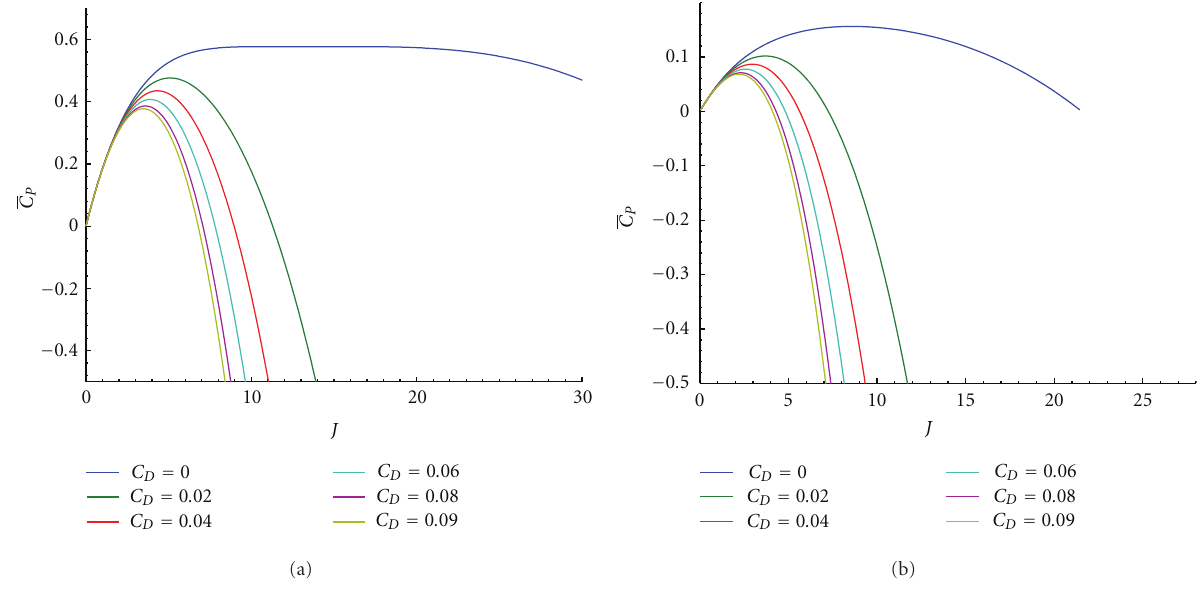
Figure 15: (a) C P versus J for θ = 2 ◦ and γ = 15 ◦ and (b) C P versus J for θ = 2 ◦ and γ = 60 ◦ .